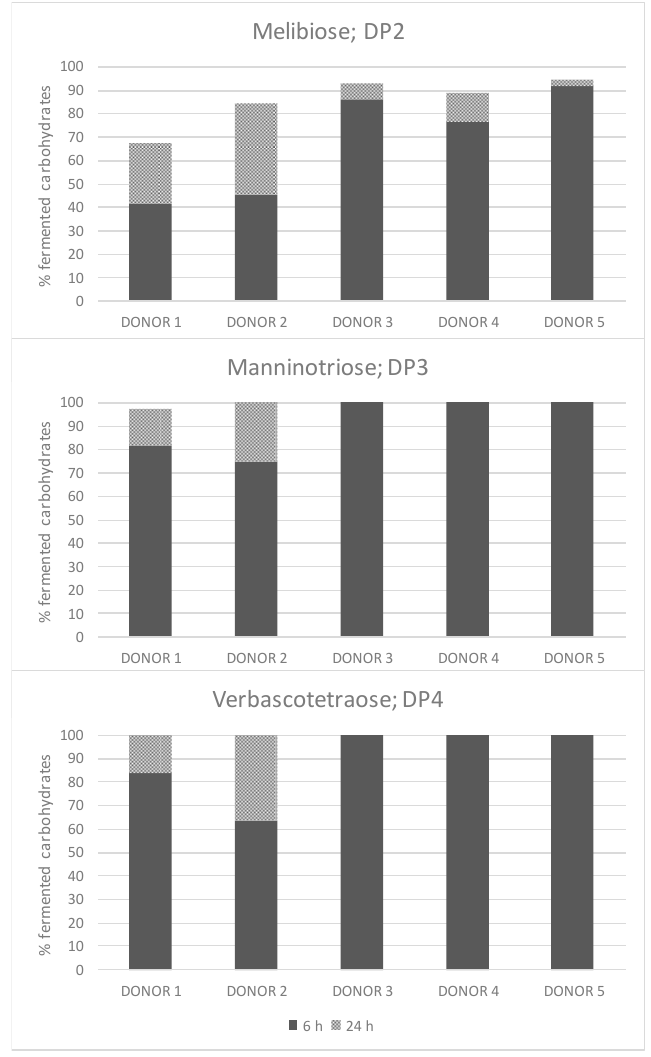
Figure 2. Relative percentage (%) of fermented melibiose (DP2), manninotriose (DP3) and verbascotetraose (DP4) following fermentation of non-fructosylated α -GOS with infant faecal samples ( n = 5). Darker and lighter colours on the bars indicate the percentage of metabolized carbohydrate after 6 and 24 h of incubation, respectively.